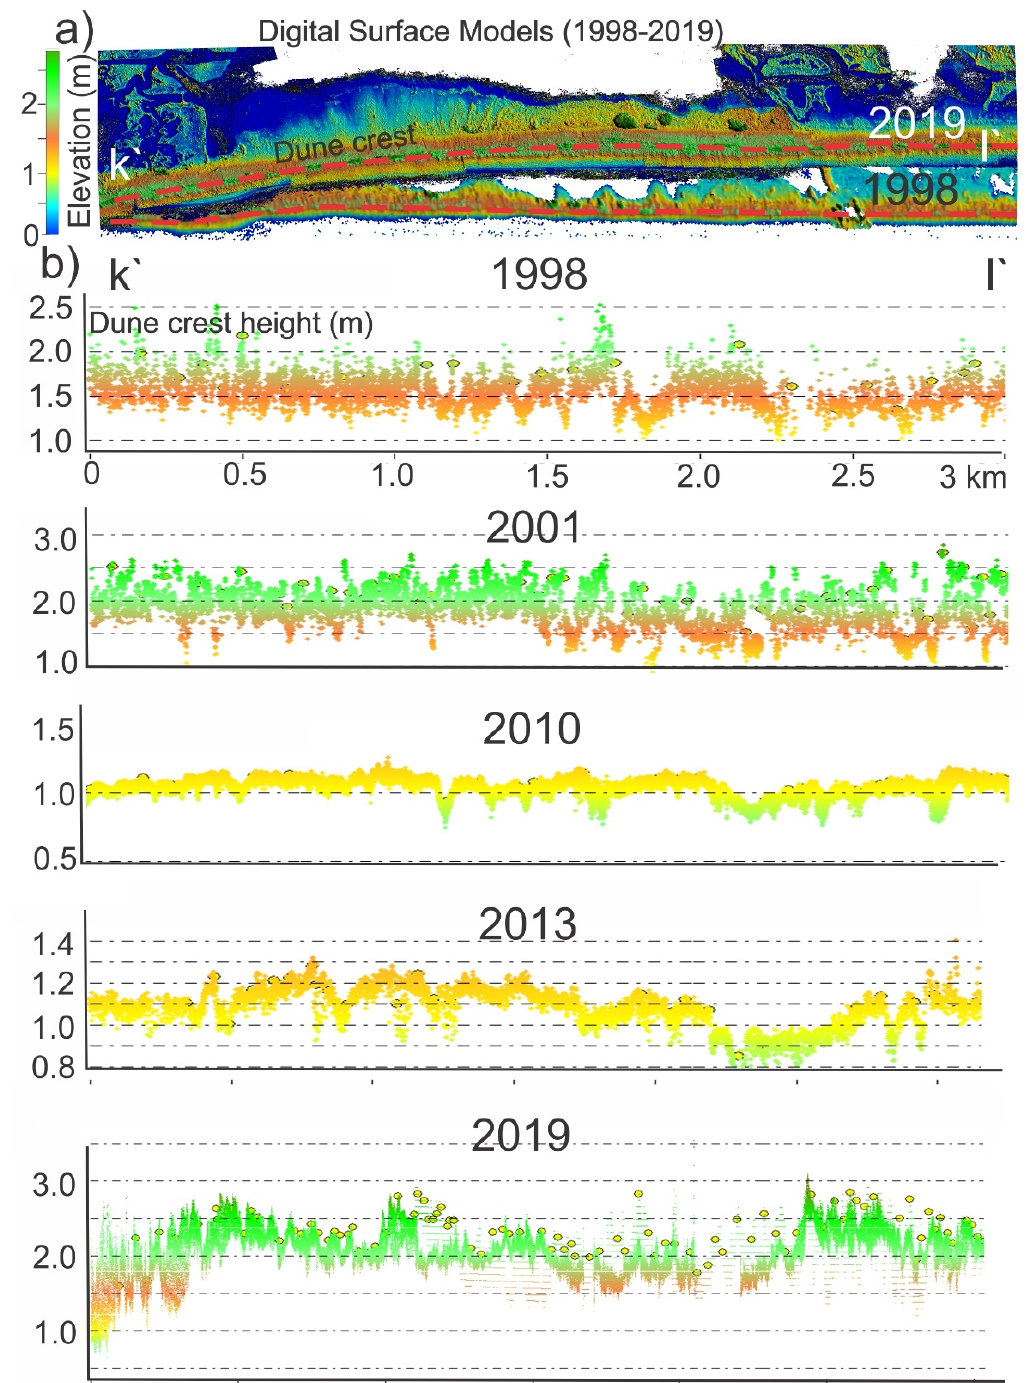
Figure 5. ( a ) Digital surface models of 1998 and 2019, and ( b ) dune crest heights along the studied beach barrier between 1998 and 2019, based on Lidar and drone data. Margin of error is ±15 cm.